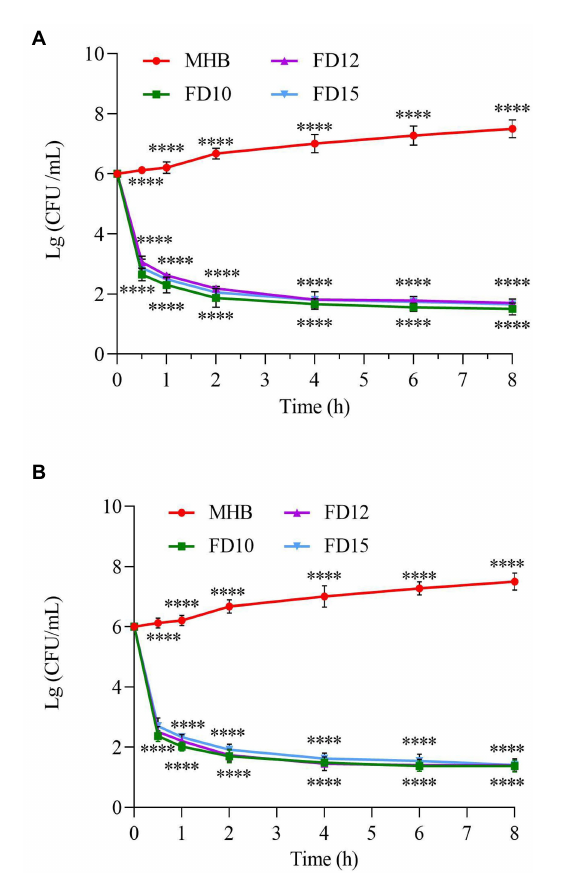
FIGURE 3 Time–kill curve of (A) E. coli ( n = 3) and (B) S. aureus CMCC(B) 26003 ( n = 3). Cells were treated with 2× MIC of FD10, FD12, or FD15, with MHB as the control. **** p < 0.0001 based on two-way